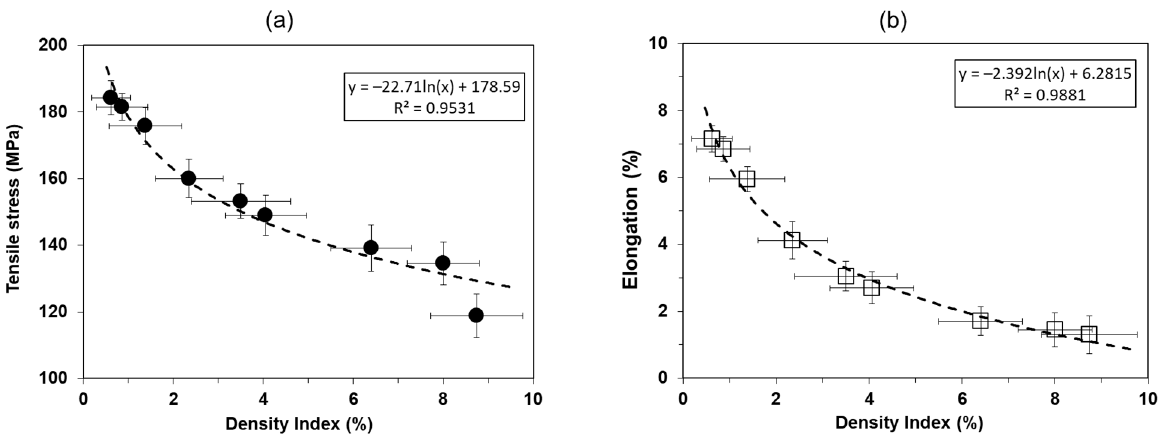
Figure 11. Correlation between the mechanical properties of the tensile bars and the Density Index values obtained by evaluating the melt quality before and after rotary and HSMC degassing. Adapted by combining data from results in a previous study [24].